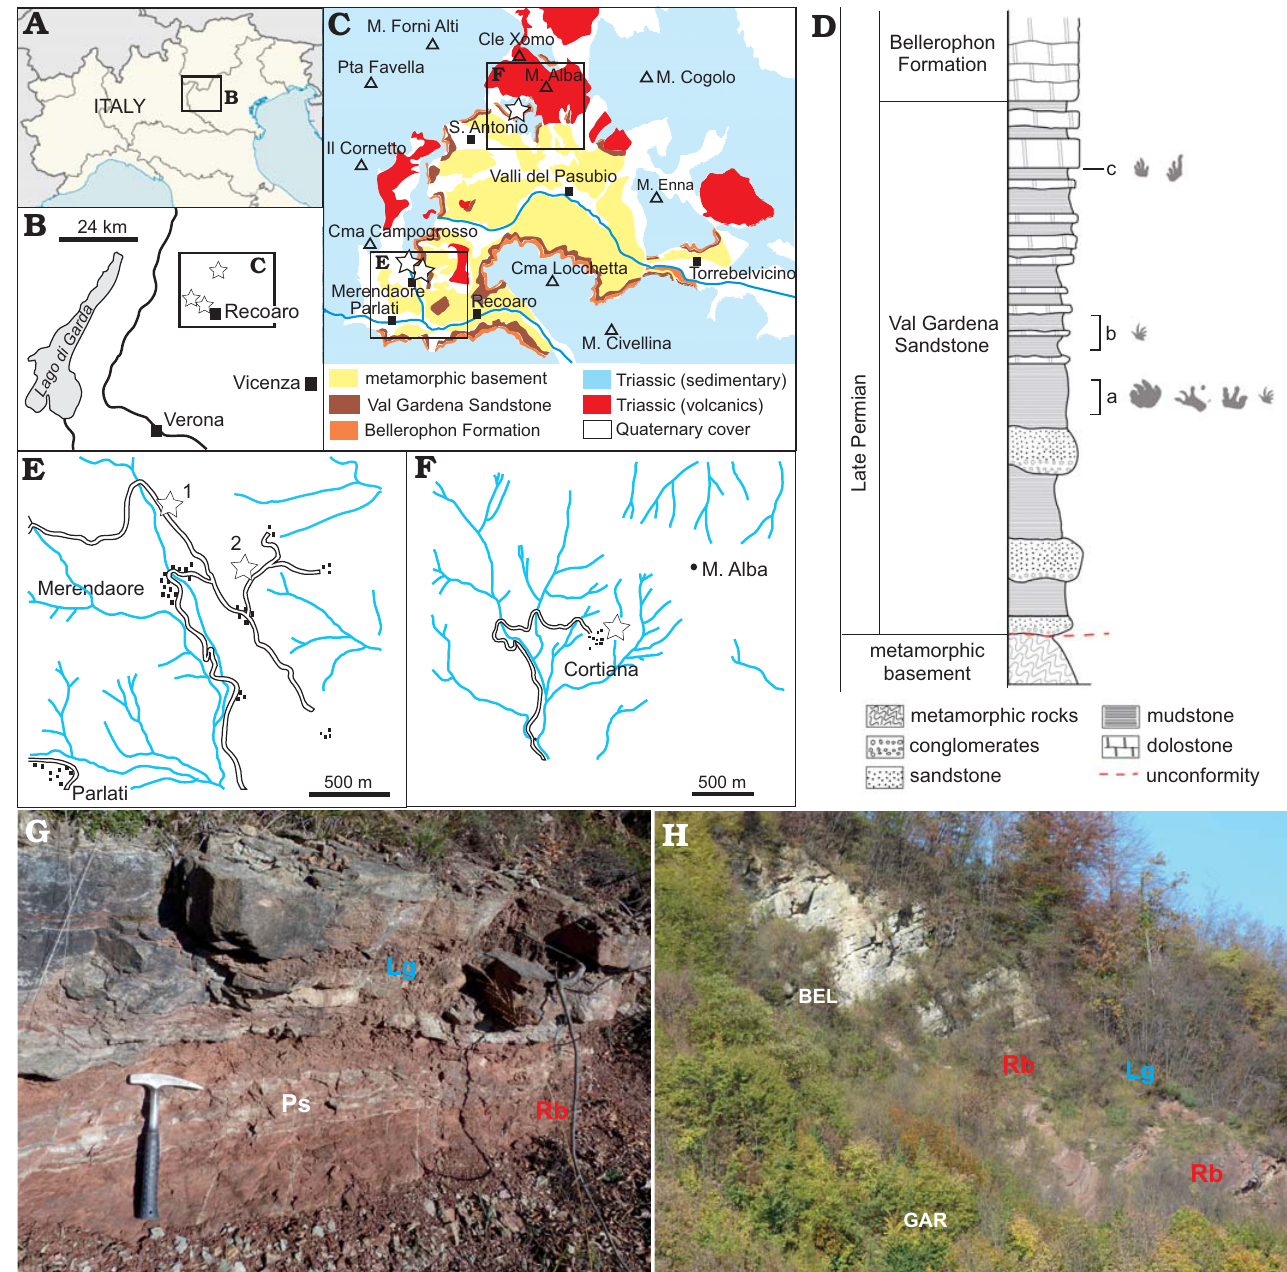
Fig. 1. Geographic location and stratigraphy of the fossil sites (asterisked). Map showing location of the study area in North Italy ( A ) and Recoaro area ( B ). Simplified geological map ( C ). D . Synthetic stratigraphic log of the Permian of Venetian Prealps (a–c, facies associations). Location of Merendaore and Ulbe ( E ) and Cortiana ( F ) fossil sites. G , H . Photographs of the Ulbe outcrops, small scale transition between lithofacies ( G ) and large scale transition between formations ( H ), with indicated transition between red bed (Rb) and lagoon (Lg) lithofacies of the topmost strata of the Val Gardena Formation, immediately before the deposition of the Bellerophon Formation. BEL, Bellerophon Formation; GAR, Val Gardena Sandstone; Lg, lagoon lithofacies (do- lostone); Ps, incipient paleosol with deep mudcracks; Rb, red bed lithofacies (laminated mudstone). Hammer for